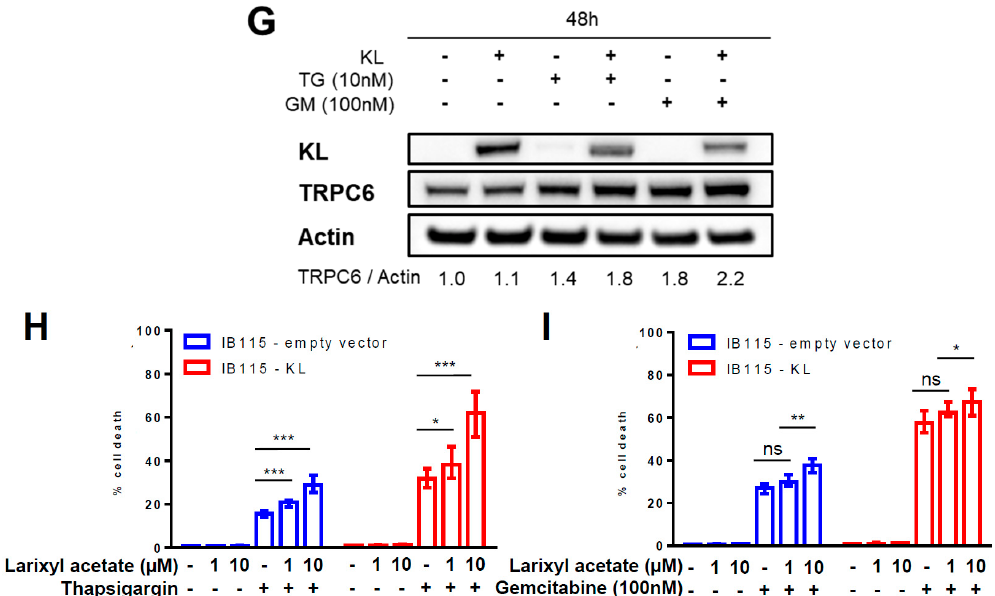
Figure 5. The intracellular localization of TRPC6 contributes to reticular Ca 2+ -leakage in KL - overexpressing DDLPS cells, but is not necessary to increase cell death. ( A – F ) Variations of